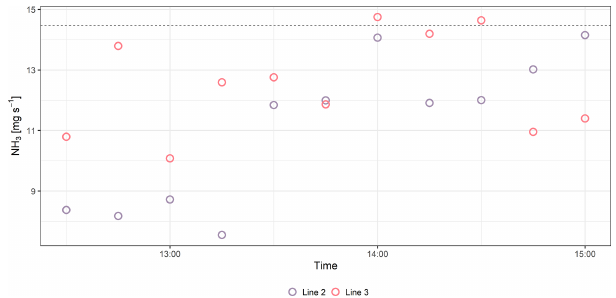
Figure 3. Ammonia (NH 3 ) fluxes measured with Line 2 and Line 3 in 10min interval averages in